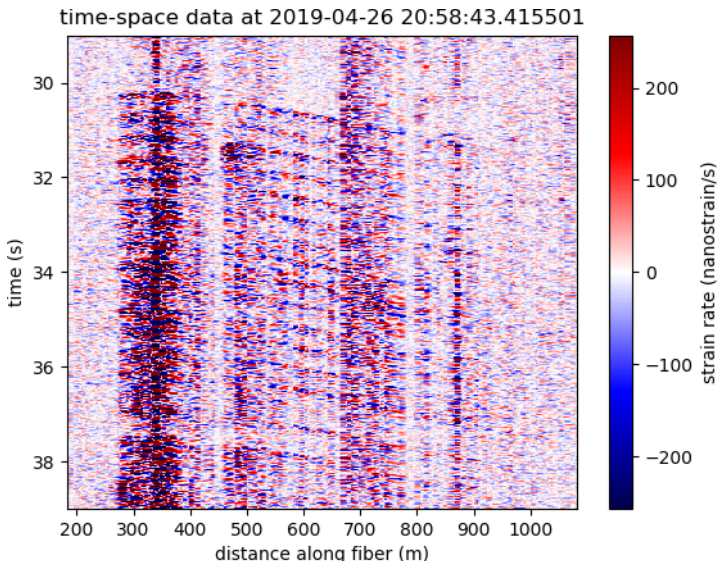
Figure 16. A short segment of seismic data from the beginning of song 2 in Fig. 15 shows evenly spaced vibrations propagating away from the stage and detected over half a kilometer